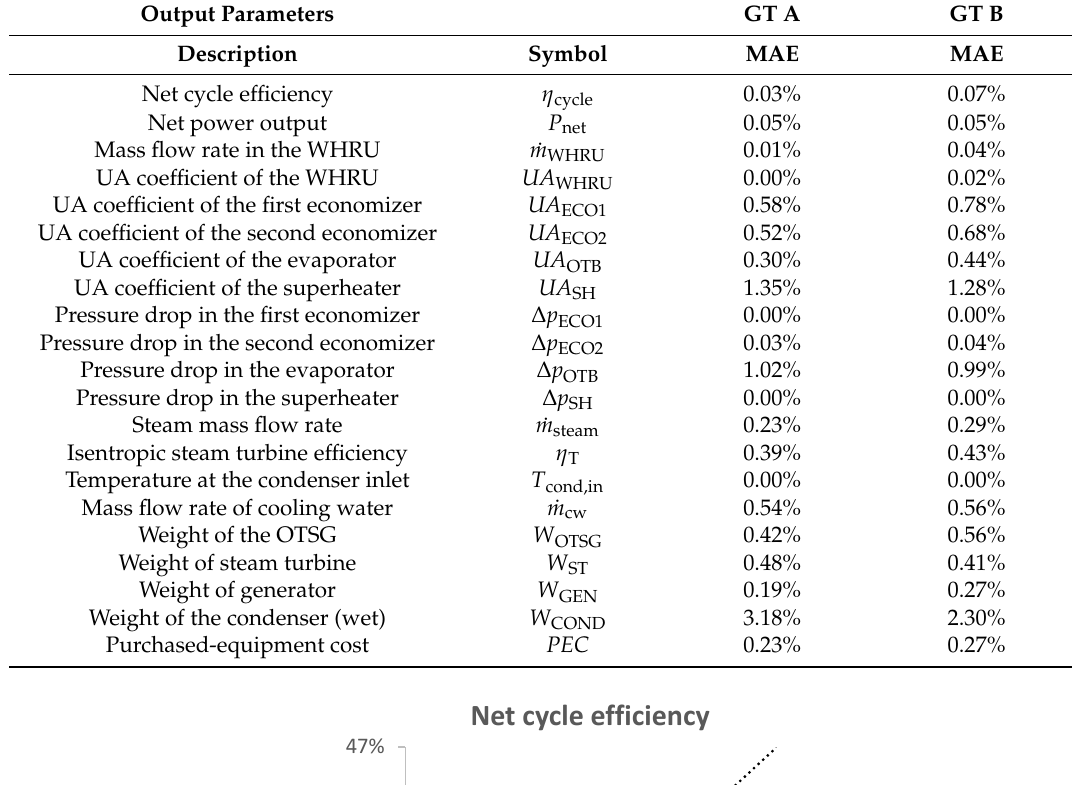
Table A1. Mean average error (MAE) of the output parameters of the Kriging model.